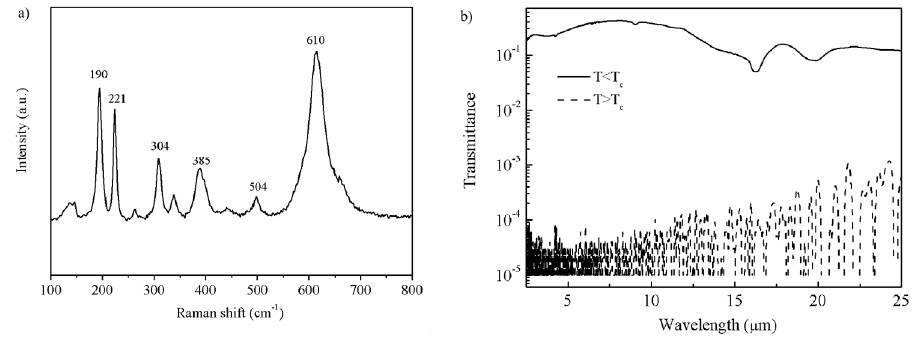
Figure 2. ( a ) Raman spectra of the VO 2 thin film; ( b ) the transmittance spectra of VO 2 thin film.